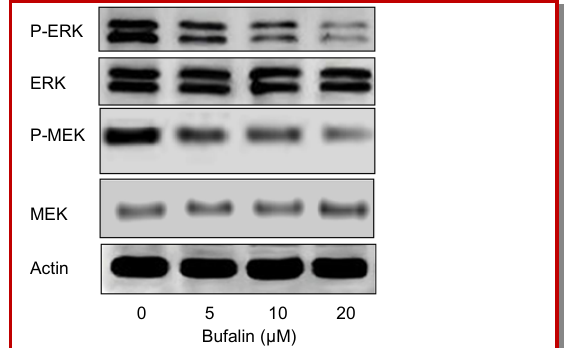
Figure 5: Bufalin treatment induces blockage of MEK/ERK signaling pathway in gastric cancer cells. Relative protein expression analysis of p-ERK, ERK, p-MEK, MEK pathway proteins from MGC-803 cancer cells incubated without or with 5, 10 or 20 µM bufalin at 37 º C for 24 hours. Experiments